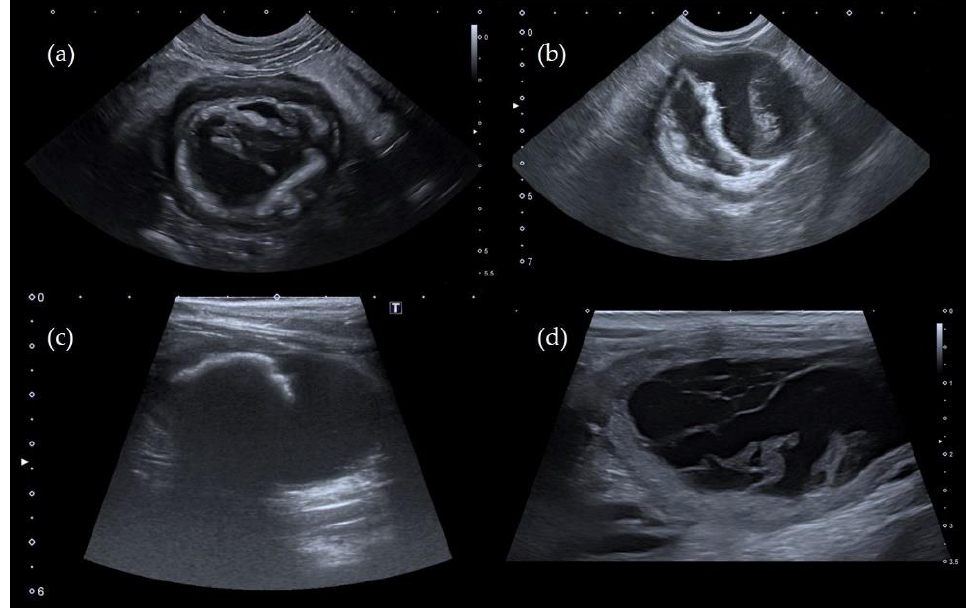
Figure 1. Ultrasound images of the urinary bladder showing the different types of adhesion pattern in three cats (image a , b , c ) and one dog (image d ). ( a ) Type 1; ( b ) Type 2; ( c ) Type 3; ( d ) Type 4. Diffuse bladder wall thickening and intraluminal echogenic sediment were present in all the cats and dogs (Table 2).